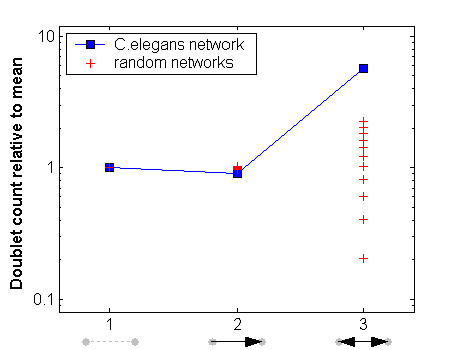
Doublet counts in the C. elegans network compared to the random matrix ensemble. Bi-directionally connected doublets are over-represented in the C. elegans network. Counts shown are for dataset 1, threshold Θ = 3, number of random matrices n = 1000. Other datasets and thresholds give similar results.